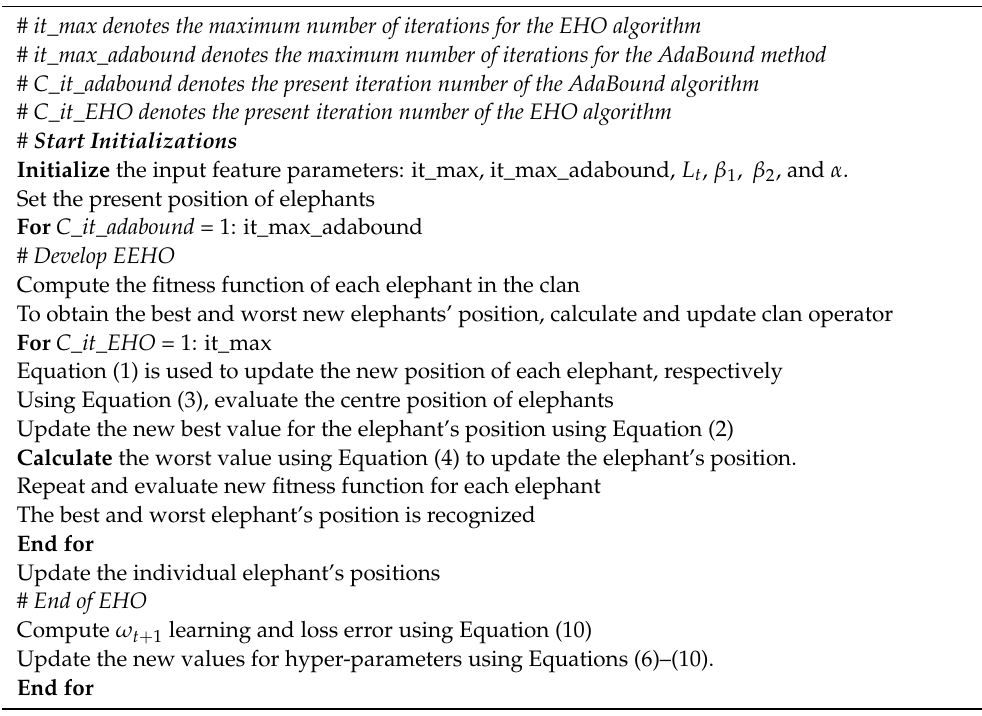
Figure 2. Flow chart of enhanced EHO with AdaBound optimizer. Algorithm 2: EEHO with AdaBound approach for updating